Question: Express in one sentence what the figure is showing.
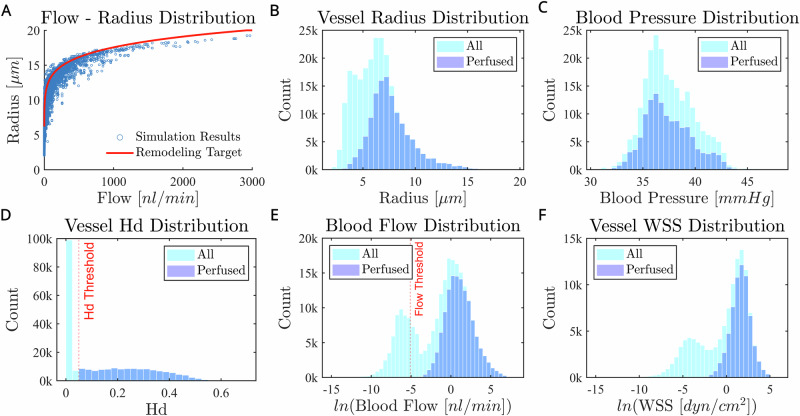
Answer: Vascular property distributions of the simulated tumor. A Scatter plot of simulated flow–radius relationships overlaid with the target flow–radius curve; B histograms of vessel radius; C blood pressure; D discharge hematocrit; E logarithmic blood flow rate; and F logarithmic vessel WSS. Perfused vessels are defined as those with both blood flow exceeding 100 µm 3 /s and discharge hematocrit greater than 0.05.